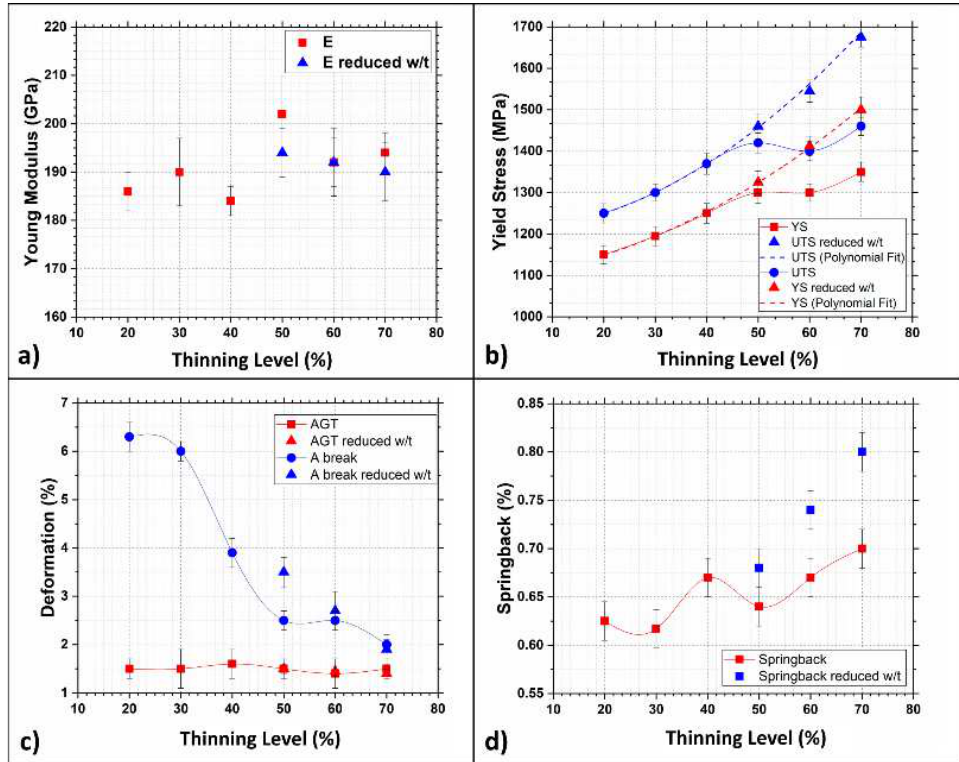
Figure 10. Evolution of mechanical properties and springback for longitudinal samples as a function of strain hardening level (orange circles and squares indicate samples with reduced w/t ratio). ( a ) Young modulus, ( b ) yield stress, ( c ) deformation and ( d ) springback effect.